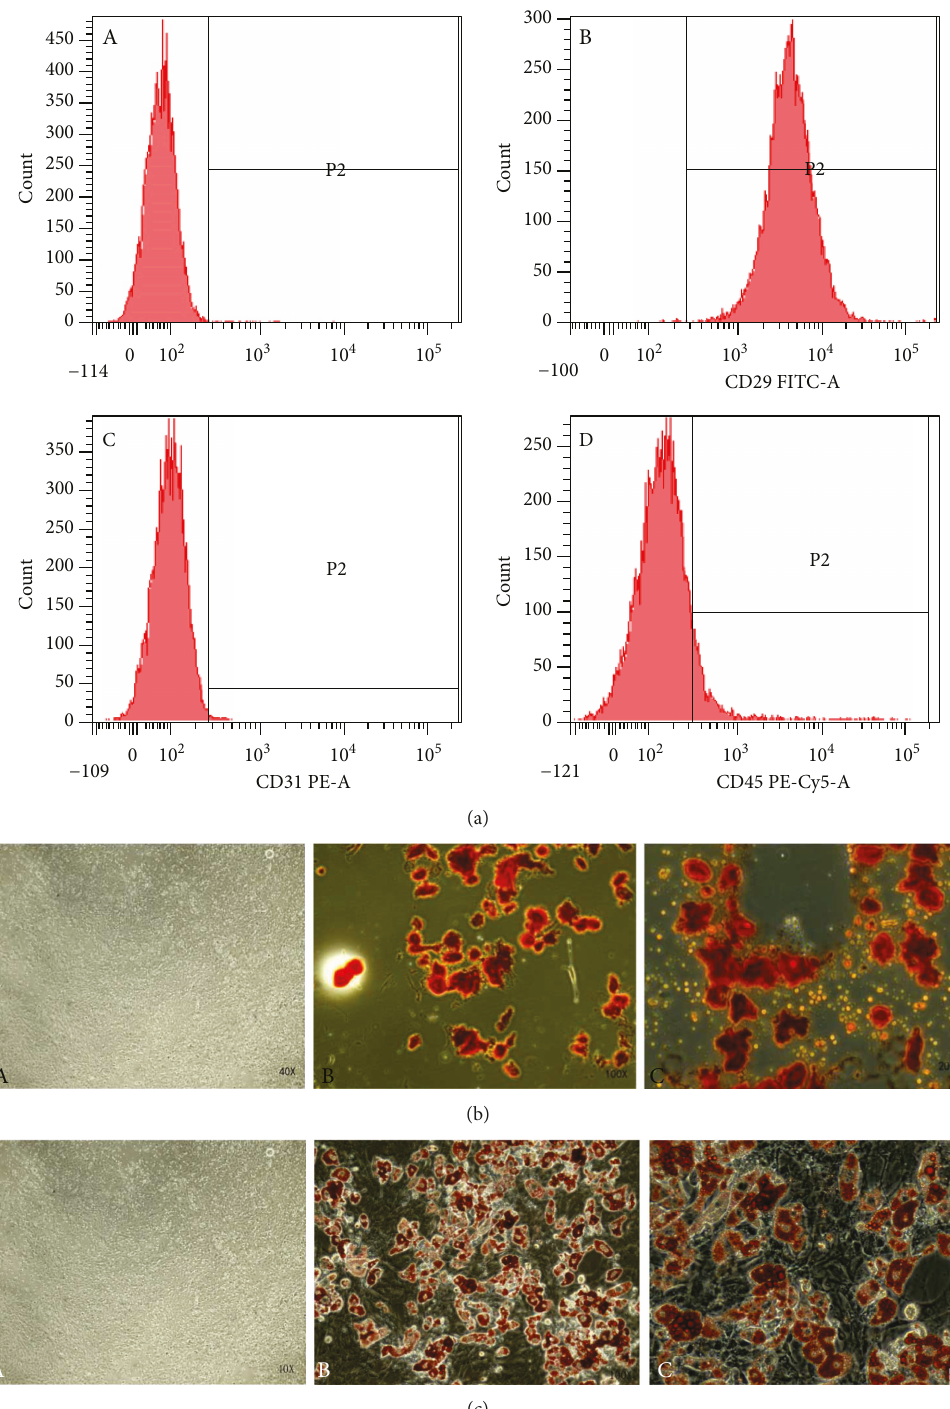
Figure 2: Identi fi cation of ASCs. (a) Cell surface antigen detection results of ASCs using fl ow cytometry. (A) Negative control ASCs treated with PBS. (B) CD29 FITC-labeled ASCs. The positive rate was 99.8%. (C) CD31PE-A labeled ASCs. The positive rate was 0.3%. (D) CD45 PE- CY5-A labeled ASCs. (b) Osteoblast induction and Alizarin Red staining of ASCs. (A) Control ASCs without induction, dyed with Alizarin Red. Magni fi cation, × 40. (B and C) Di ff erentiated ASCs dyed with Alizarin Red. Red mineralized nodules can be observed. Magni fi cation, × 100 (B) and × 200 (C). (c) Adipogenic induction and Oil Red O staining of ASCs. (A) Control ASCs without induction, dyed with Oil Red O. Magni fi cation, × 40. (B and C) Di ff erentiated ASCs dyed with Oil Red O; cells showed red droplet formation. Magni fi cation, × 100 (B) and × 200